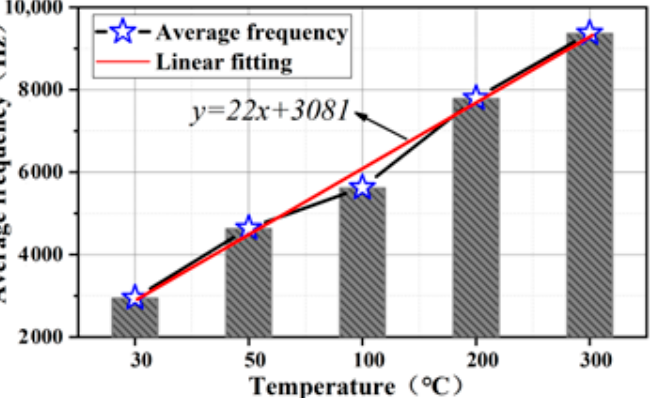
Figure 8. The average frequency of the main frequency of coal under different temperature condi-